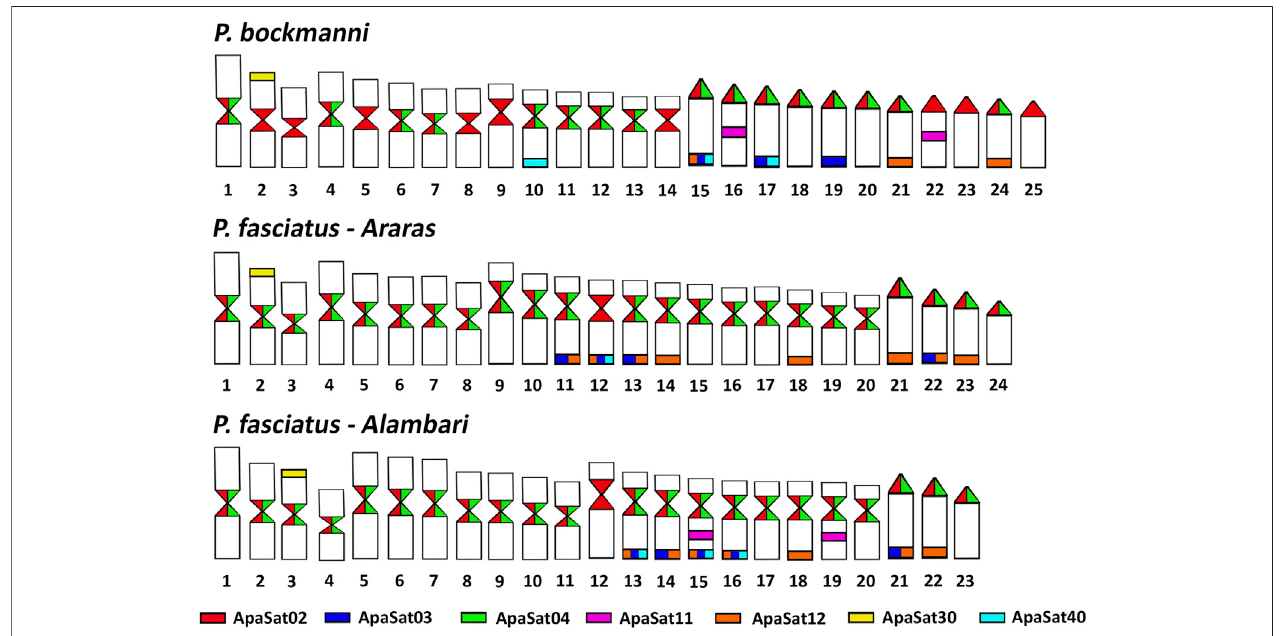
FIGURE3| IdeogramofclusteredconservedsatDNAsin Psalidodonbockmanni andtwopopulationsof Psalidodonfasciatus .Nosignalwasobservedin Astyanax lacustris .